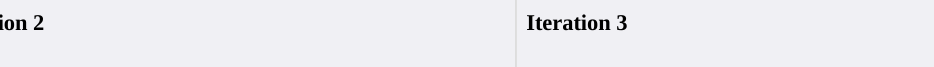
Table 1. An overview of the course changelog from the first to third